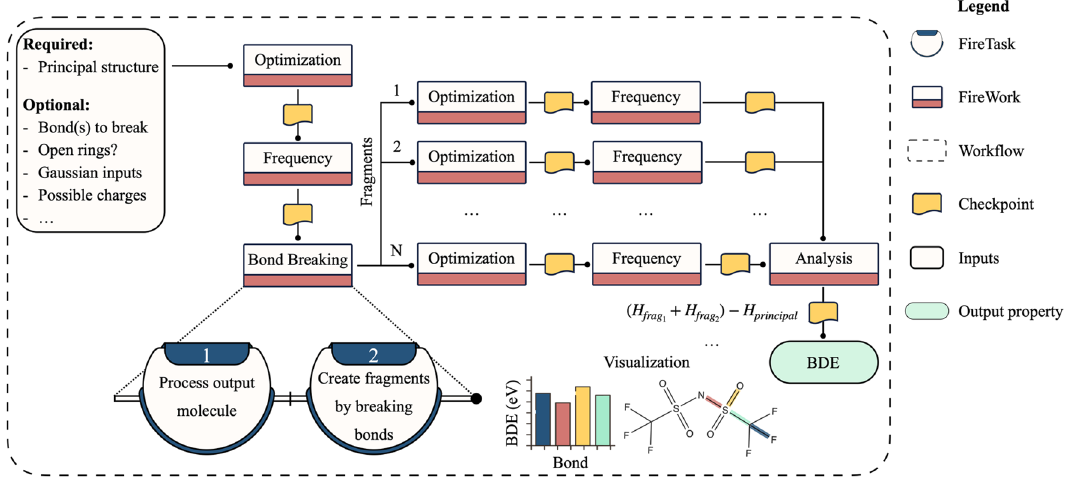
Figure 5. Workflow diagram for the bond dissociation energy